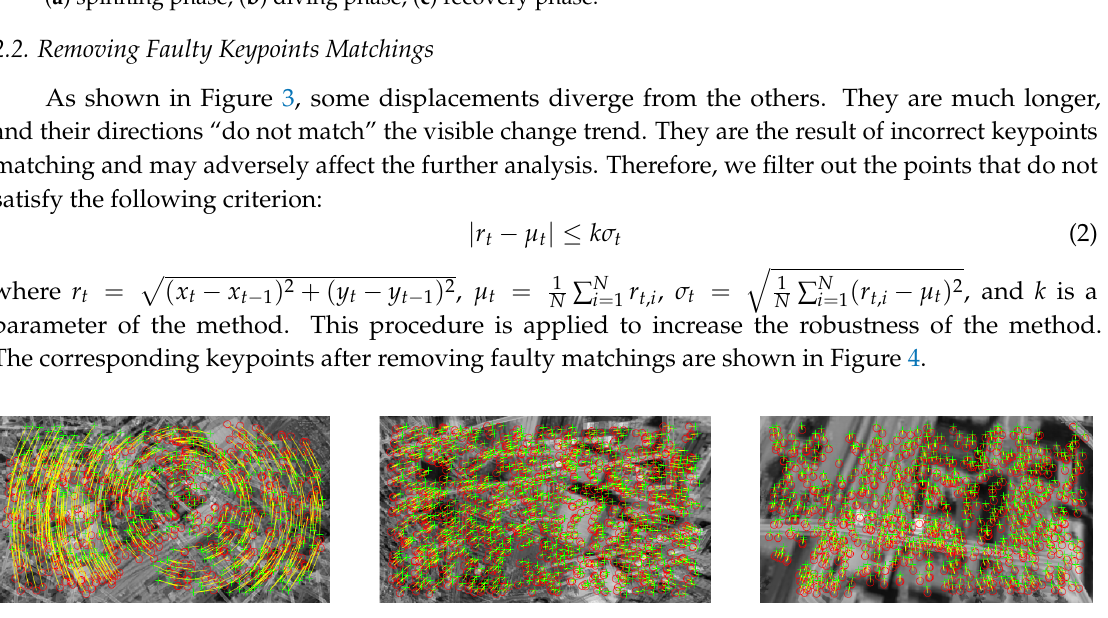
Figure 3. SURF keypoints determined at t − 1 (red circles) and t (green crosses) connected by displacements (yellow segments) plotted on t − 1 and t frames superimposed using alpha blending for: ( a ) spinning phase, ( b ) diving phase, ( c ) recovery phase.